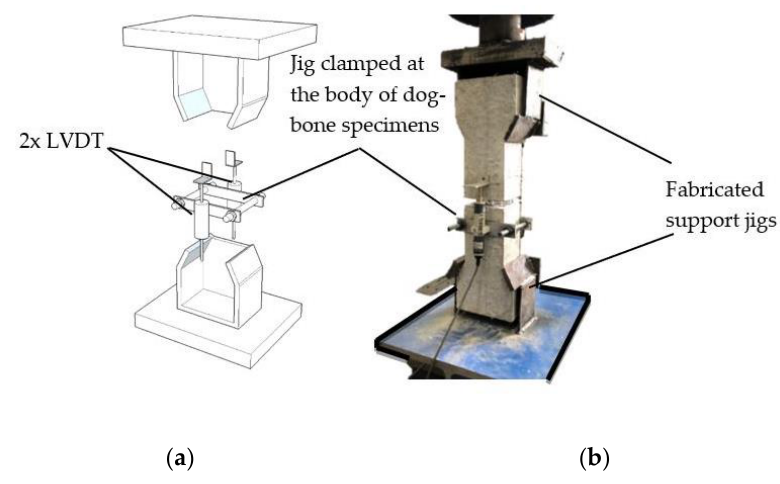
Figure 3. The uniaxial tensile test: ( a ) conceptual, ( b ) actual.